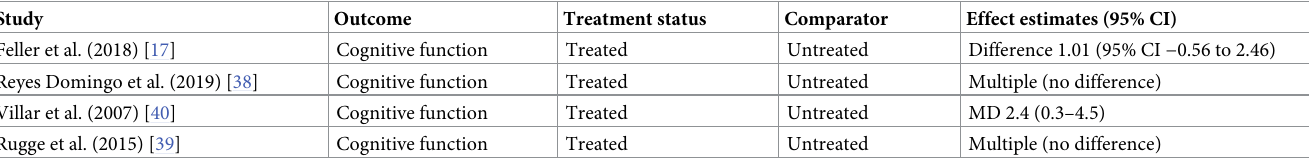
Table 9. Primary review findings on cognitive